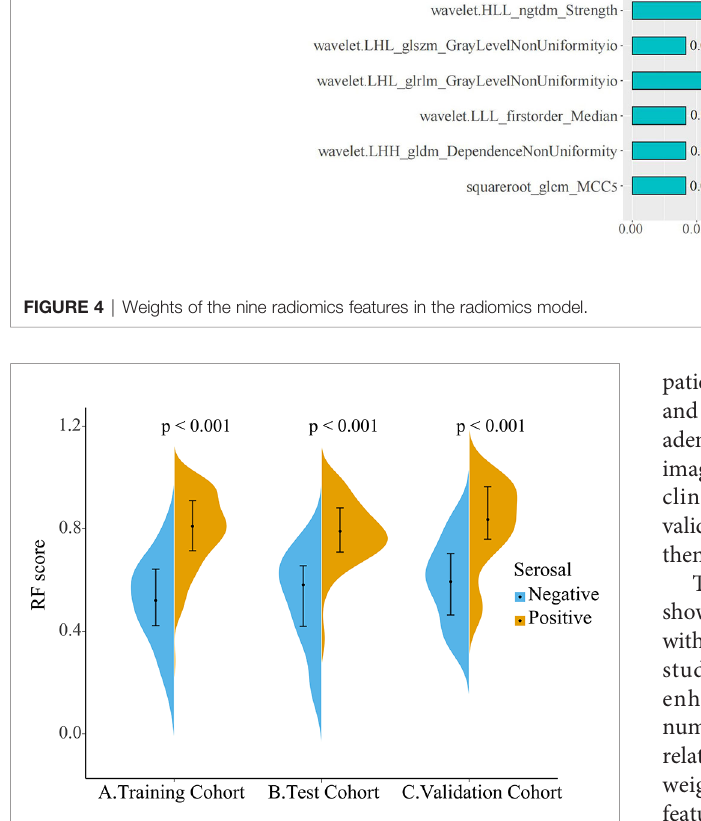
FIGURE 5 | Violin plot of Rad-score distribution in the training (A) , testing (B) , and independent validation cohort (C) , with the outermost shape showing the density at that location. The dot on the black line is the median and the black line from the top to the end range is from the lower quartile to the upper